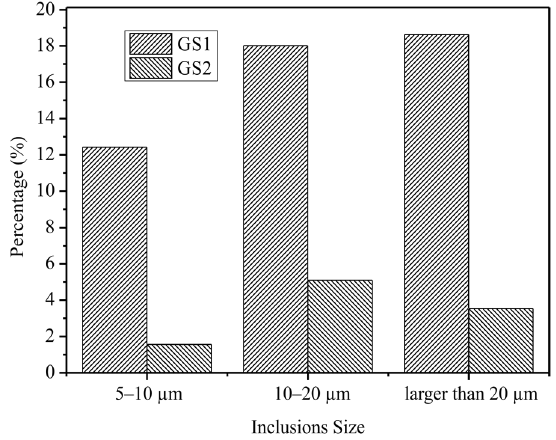
Figure 3. Pure MnS size comparison between the two samples.